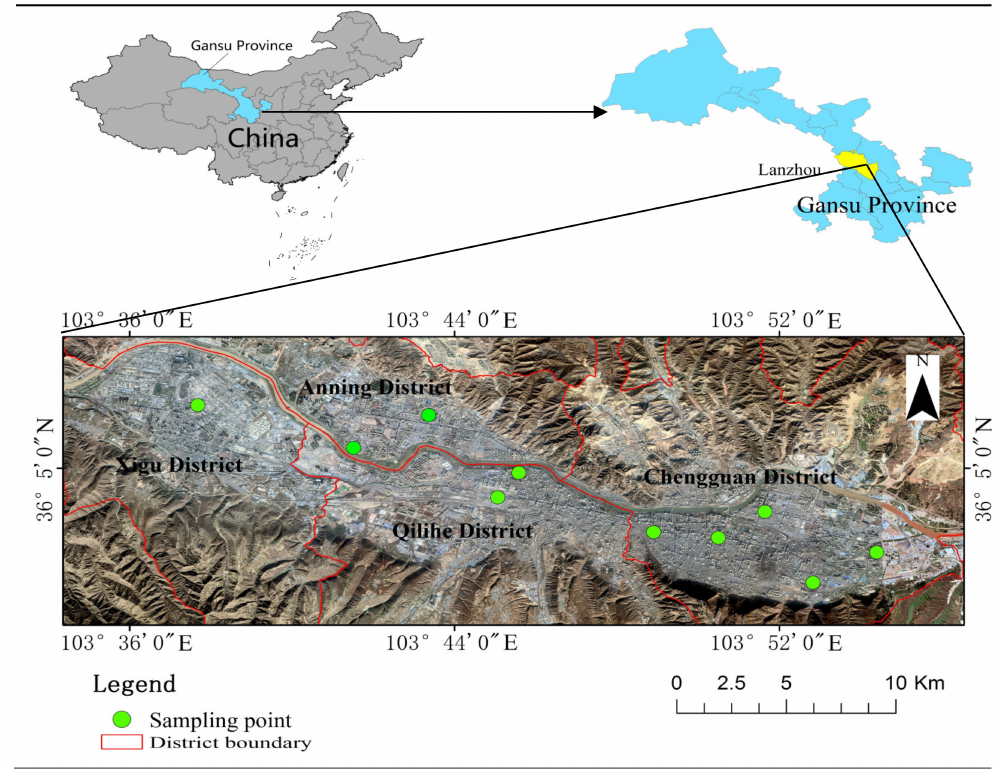
Figure 1. Study area and sampling